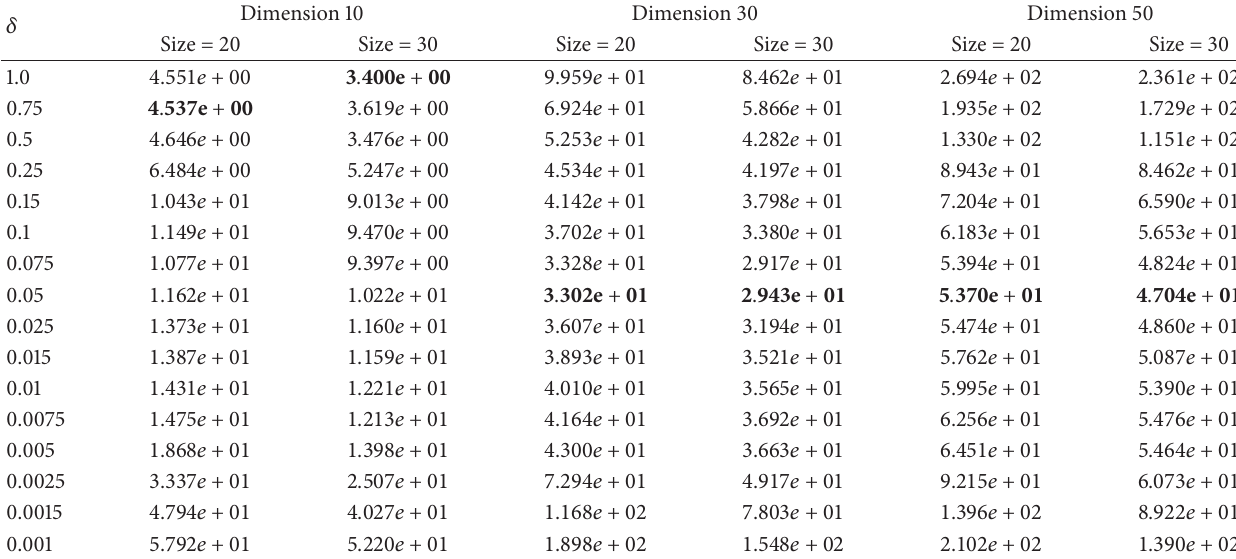
Table 10: Different values of parameter 𝛿 and respective mean best fitness for Rastrigin test